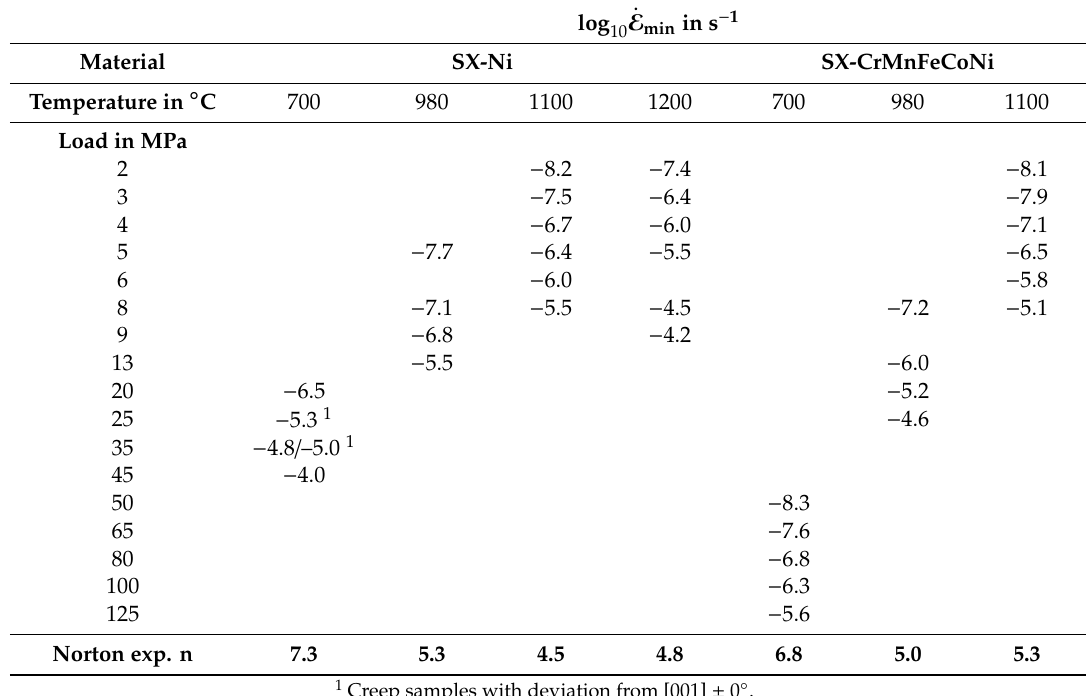
Table 1. Minimum creep rates and stress exponents for the creep tests of pure nickel and CrMnFeCoNi at di ff erent loads and temperatures under vacuum.